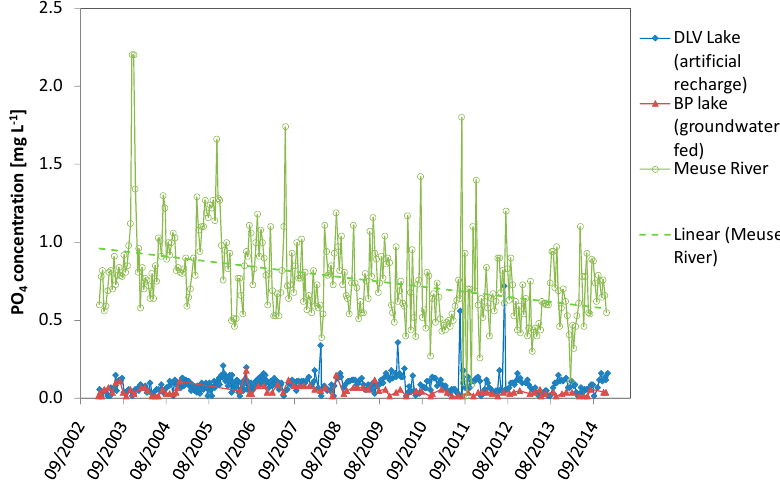
Figure 9. Total PO 4 concentration of gravel pit lake with artificial recharge (DLV Lake), groundwater fed only (BP Lake) and Meuse River from 2002 to 2014.